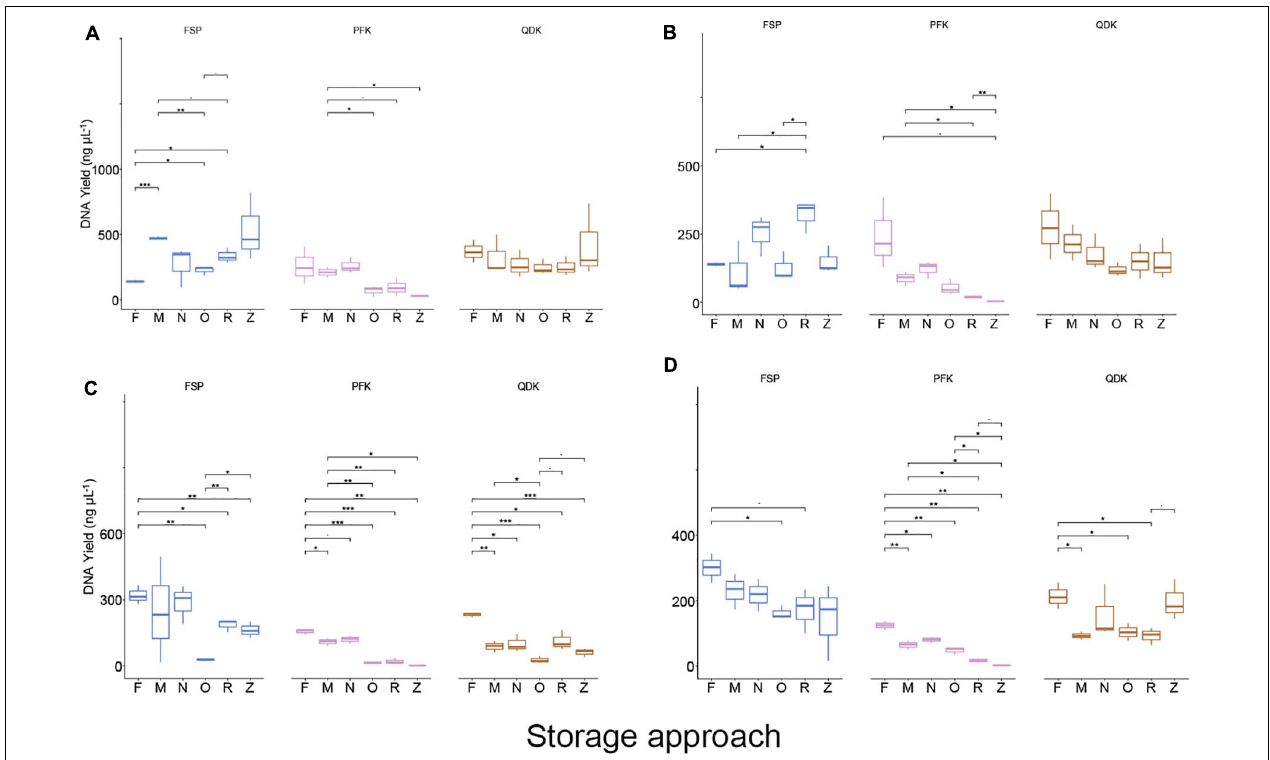
FIGURE 6 | DNA yields from livestock intestinal and fecal samples using different storage conditions and isolation kits. Boxplots showing the DNA yield (ng µ L − 1 ) after extracting the livestock bacterial community from chicken cecum (A) , chicken feces (B) , pig ileum (C) , and pig feces (D) . Values represent averages from triplicate DNA extractions. Kruskal–Wallis test FDR corrected, * P < 0.05, ** P < 0.01, *** P < 0.001, and - P < 0.09, respectively.